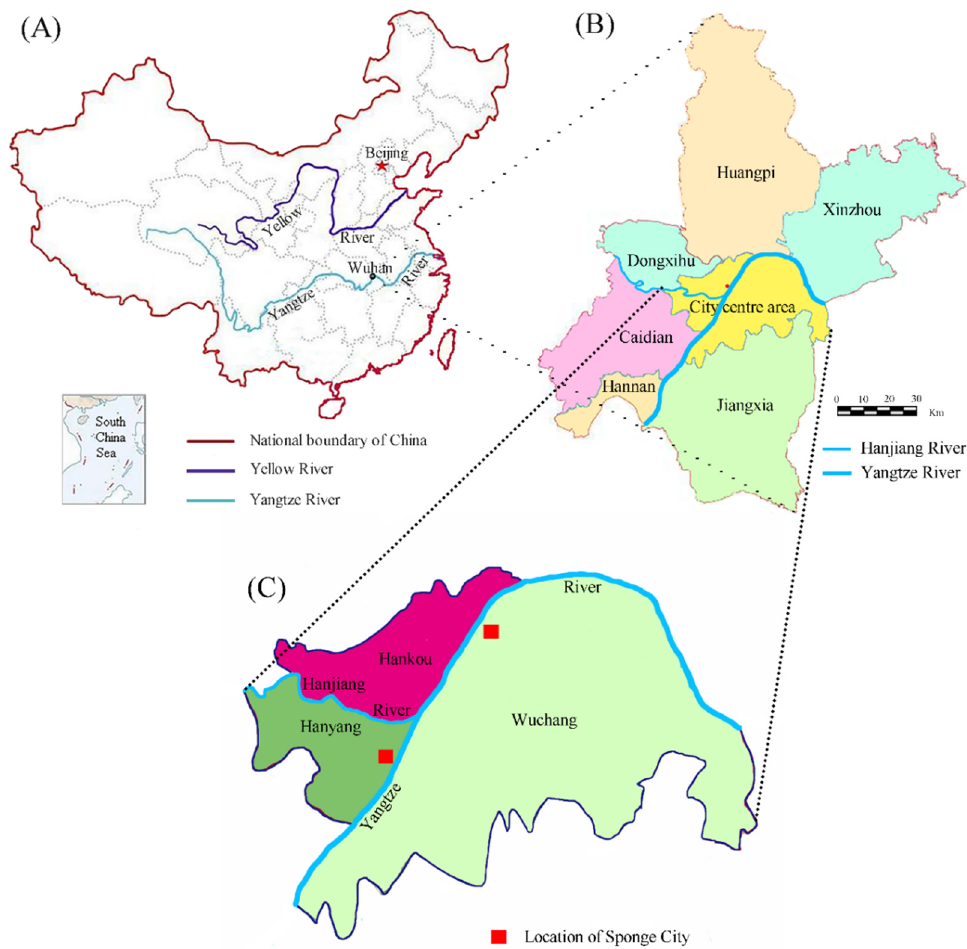
Figure 1. The study area; ( A ) the location of Wuhan City; ( B ) Wuhan about Yangtze River; ( C ) central districts in Wuhan about the pilot sites of Sponge City (source: Shan Zheng).